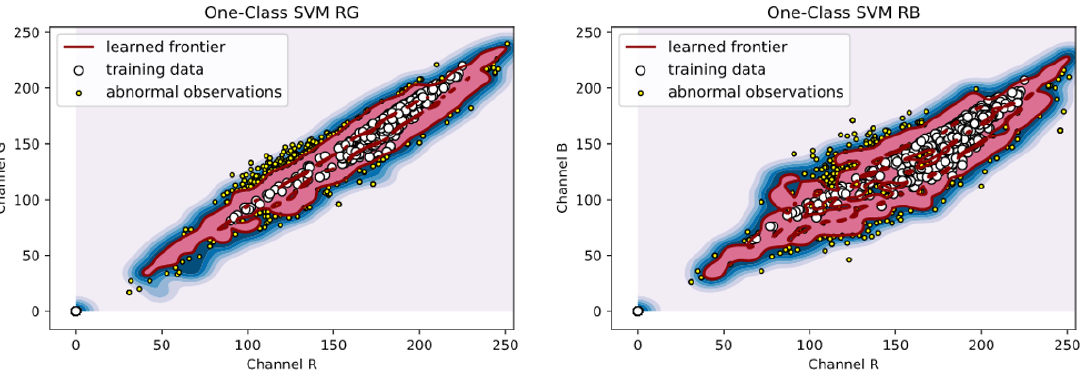
Figure 4. Resulting trained-frontier for the background color classifier considering two color channel